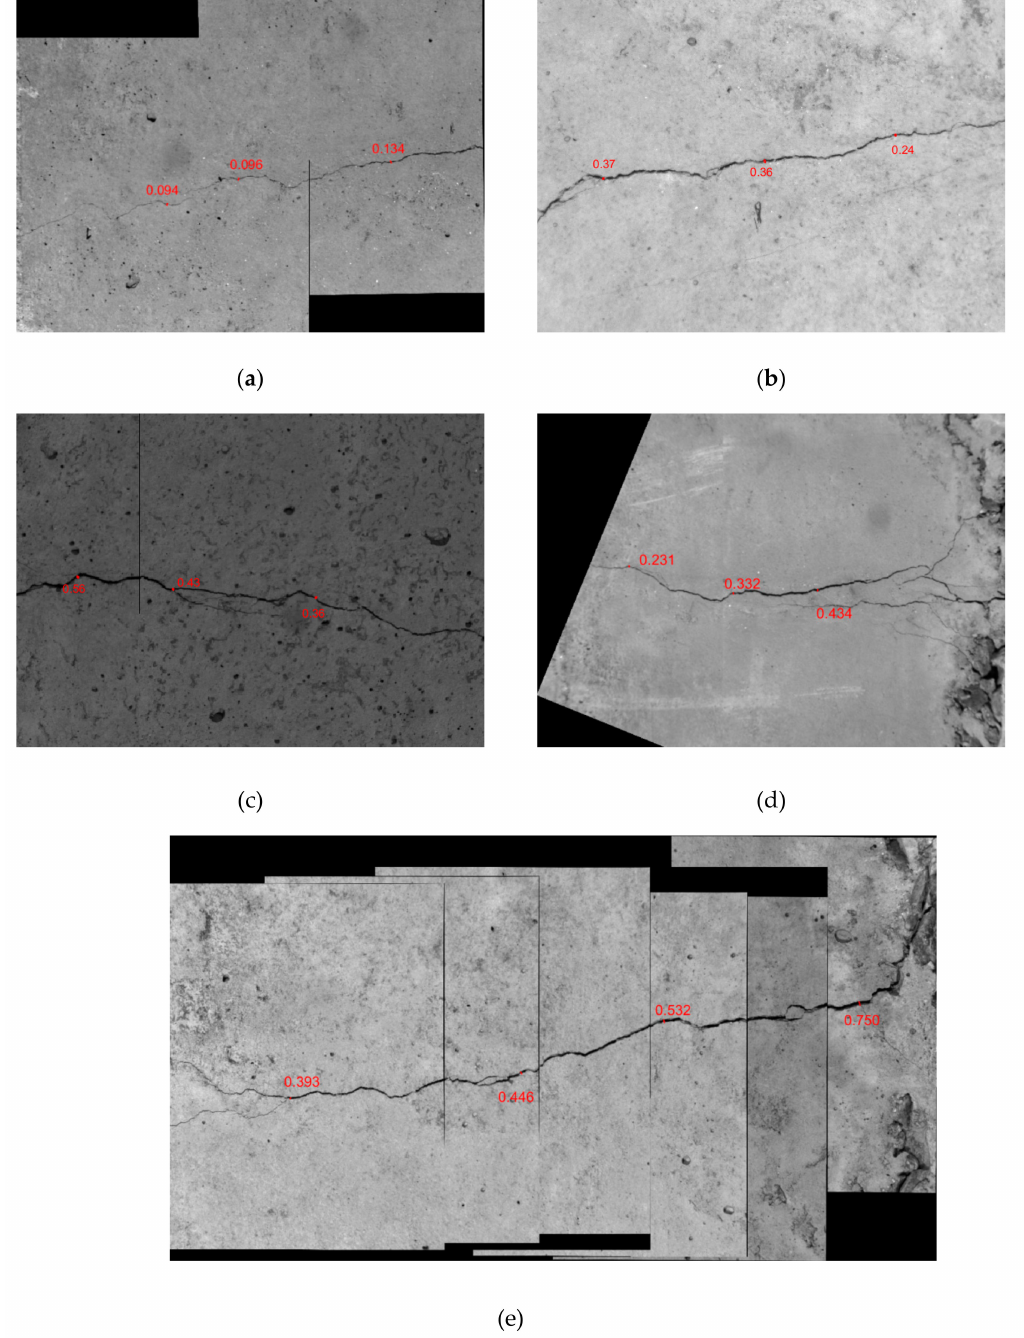
Figure 20. Image stitching results. ( a ) Splicing of fine cracks at the ends; ( b ) Splicing of cracks under good light conditions; ( c ) Splicing of cracks under poor lighting conditions; ( d ) Splicing of cracks under strong noise interference conditions; ( e ) Splicing of complete cracks under multiple